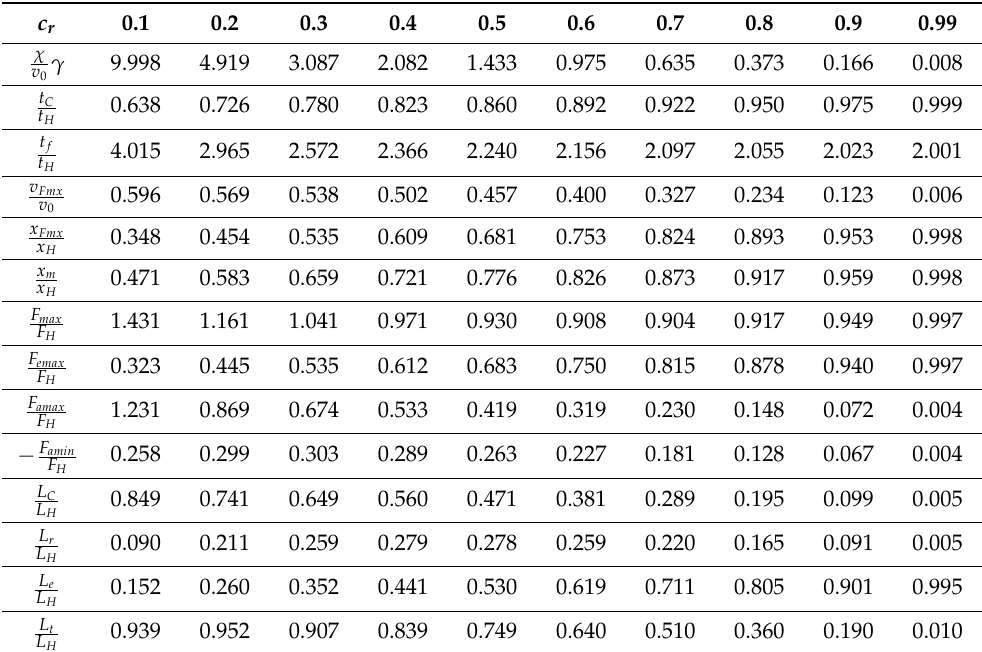
Table 1. Normalized impact parameters for a range of values of coefficient of restitution, c r